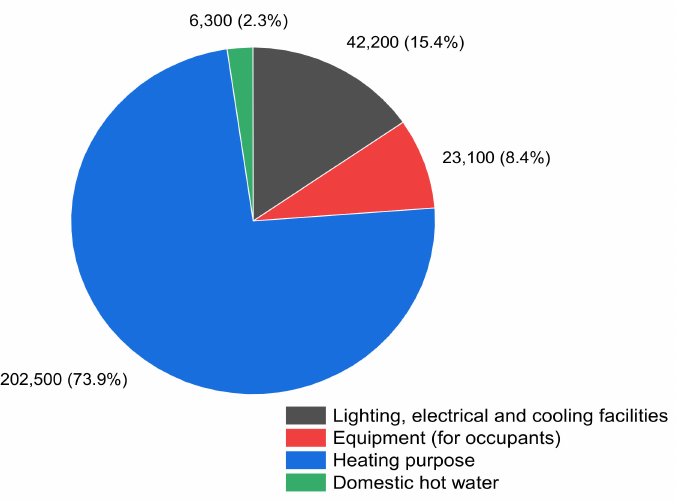
Figure 16. Breakdown of the building’s annual energy consumption in kWh for case B (with low-E film).